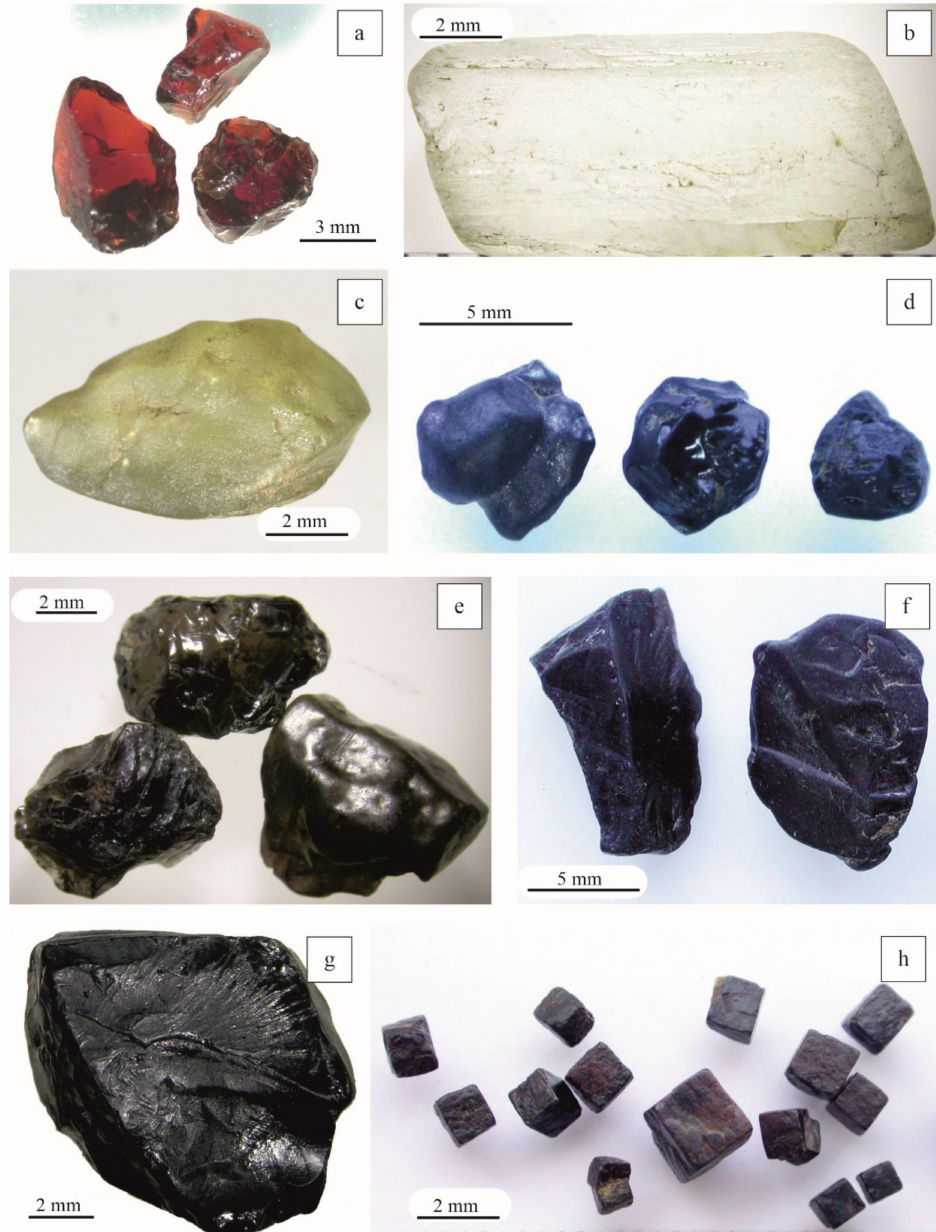
Figure 9. Minerals of the Naryn-Gol placer. ( a )—garnet, ( b )—feldspar, ( c )—olivine, ( d )—spinel, ( e )—orthopyroxene, ( f )—clinopyroxene, ( g )—ilmenite, and ( h )—pseudomorphs after pyrite. Garnet is represented by pyrope–almandine Prp 0.545, Alm 0.312, Grs 0.118 (Figure 9a); feldspar by sanidine (Figure 9b); olivine by forsterite with Mg # 90.27 (Figure 9c); spinel by pleonaste low in chromium (0.57 wt. %) and in titanium (0.81 wt. %) (Figure 9d); orthopyroxene by enstatite (Figure 9e); and clinopyroxene by Ti-bearing augite (Figure 9f). Large silver-black ilmenite, on the whole, resembles spinel but is distinguished by a flinty fracture (Figure 9g)